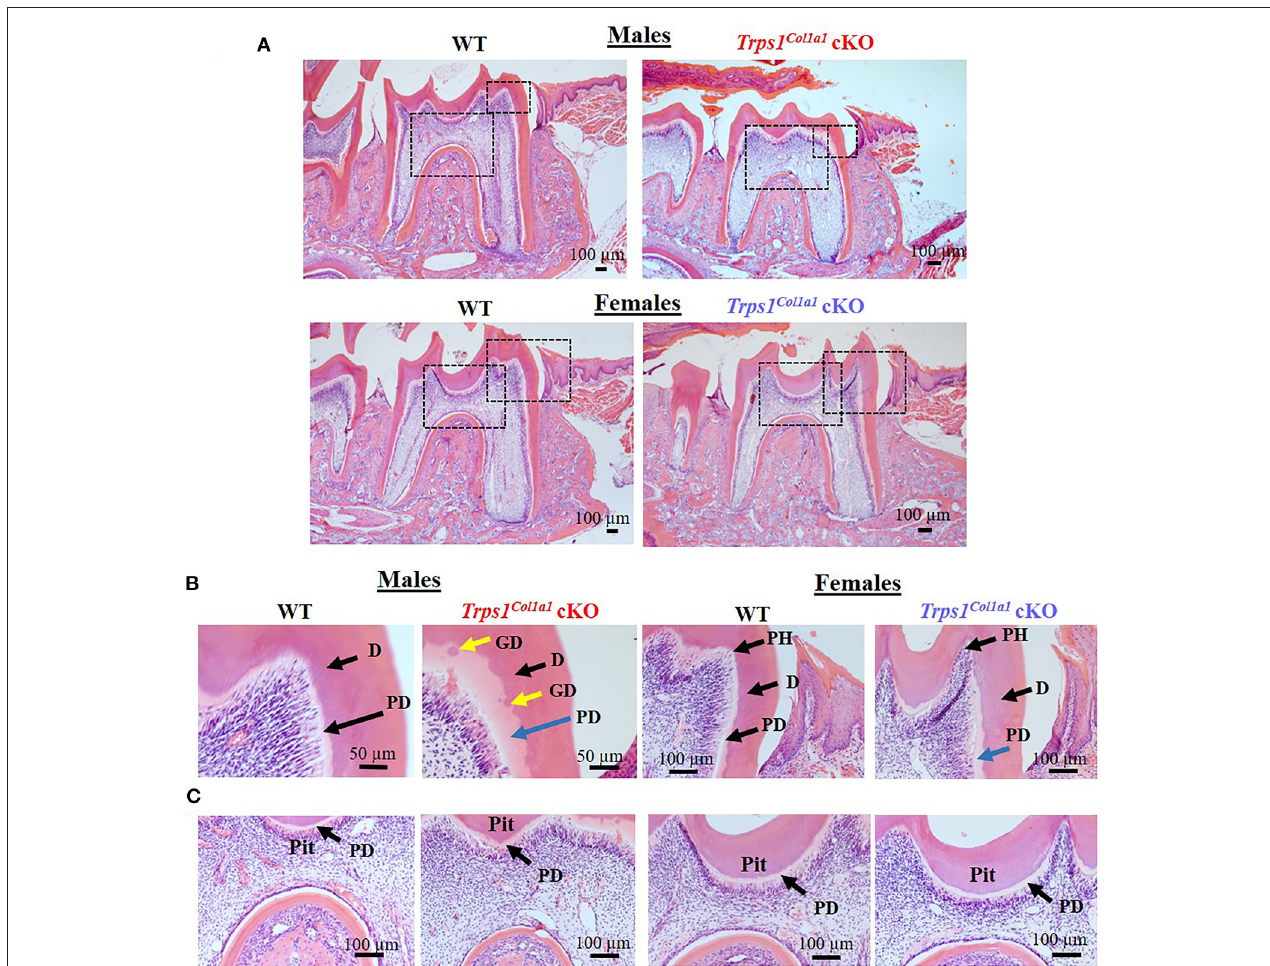
FIGURE 6 | Histological evaluation (H&E staining) of the mandibular first molar crown tissues in 4wk old WT and Trps1 Col1a1 cKO mice. (A) Low magnification images showing gross histological appearance of molars. Boxed areas are shown in higher magnification on panels B and C. (B) High magnification of the mesial cusp showing wider predentin in Trps1 Col1a1 cKO males (blue arrow) and irregular mineralization of crown dentin with calcospherites (globular dentin, yellow arrow). Note the pronounced pulp horns (arrows) in Trps1 Col1a1 cKO females. (C) High magnification of the pit area. Note the deeper appearance of the pit in Trps1 Col1a1 cKO males. Pulp horn (PH), dentin (D), predentin (PD), globular dentin (GD). N = 3 mice/genotype were